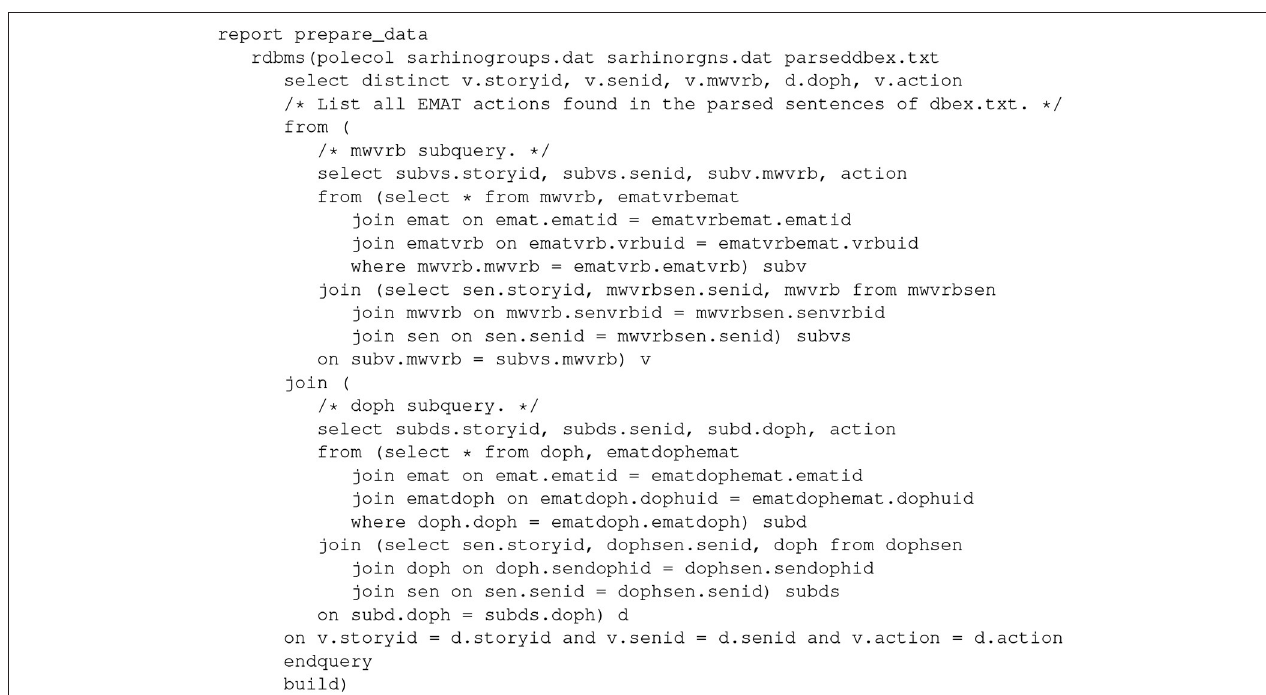
FIGURE 2 | An rdbms_() relation to build the polecol EMAT database of Example 2 and query it for EMAT actions.